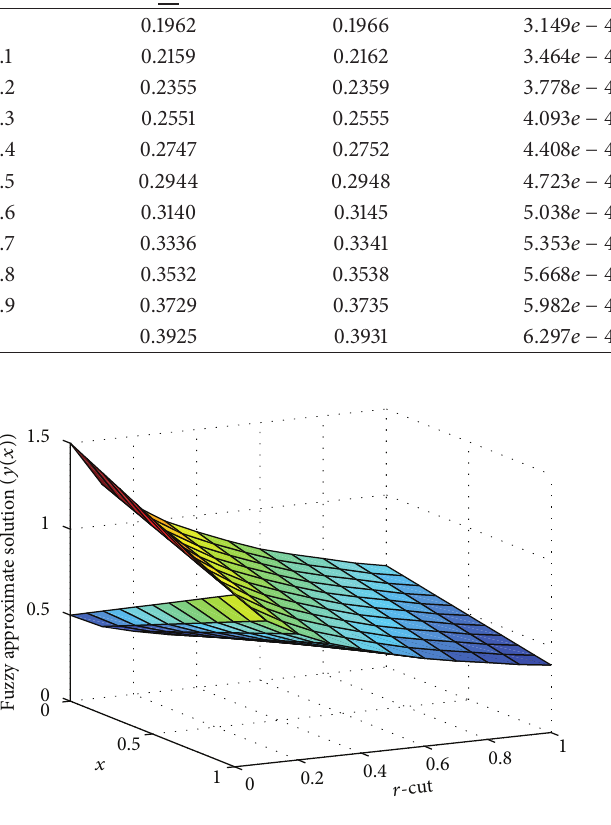
Figure 5: The fuzzy approximate solution of Example 52, Case 2. 𝛼 = 0.75, 𝑚 = 9